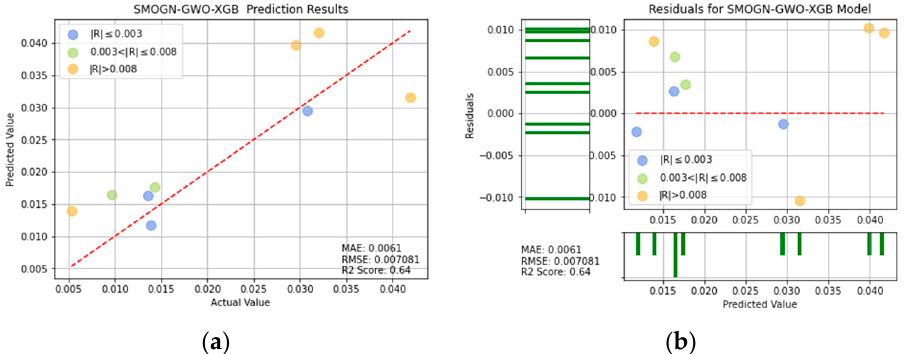
Figure 20. SMOGN-GW-XGB prediction results: ( a ) comparison of actual and predicted precision values, and ( b ) residual plot.